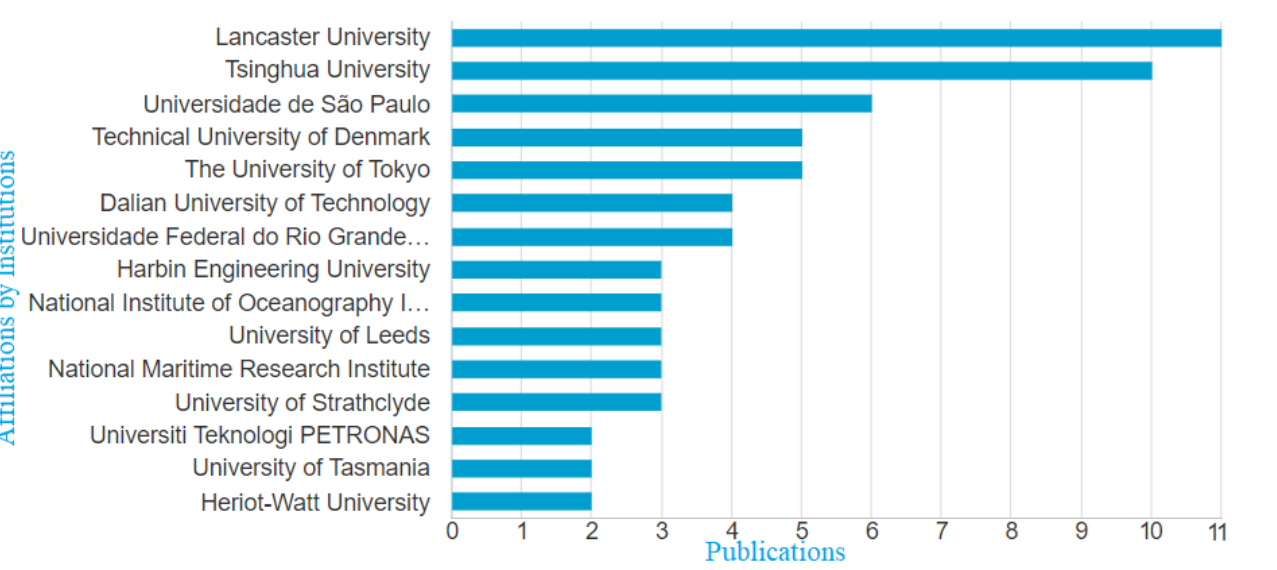
Figure 11. The affiliations by industry companies for the research on “marine hose” (data retrieved from Scopus database, 24 July 2022).